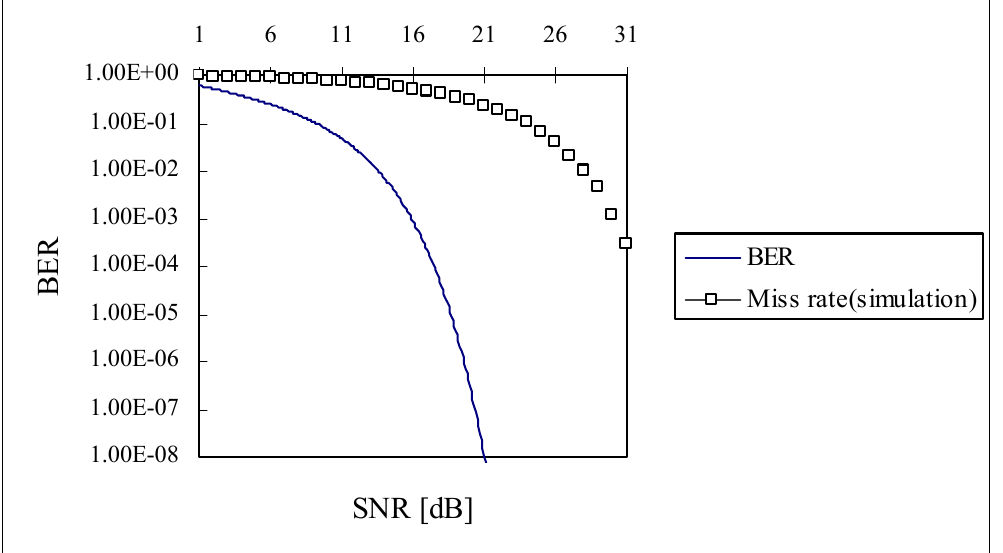
Figure 9 . Comparison between miss rate and